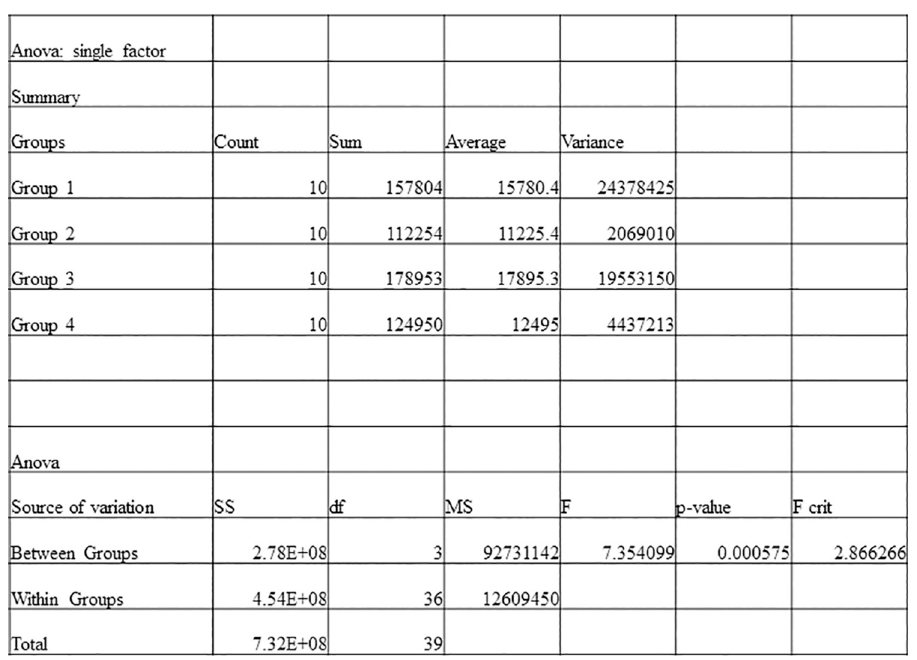
Fig 7. One-way analysis of variance to determine statistical significance in the difference in means of air particles cleared in each group.